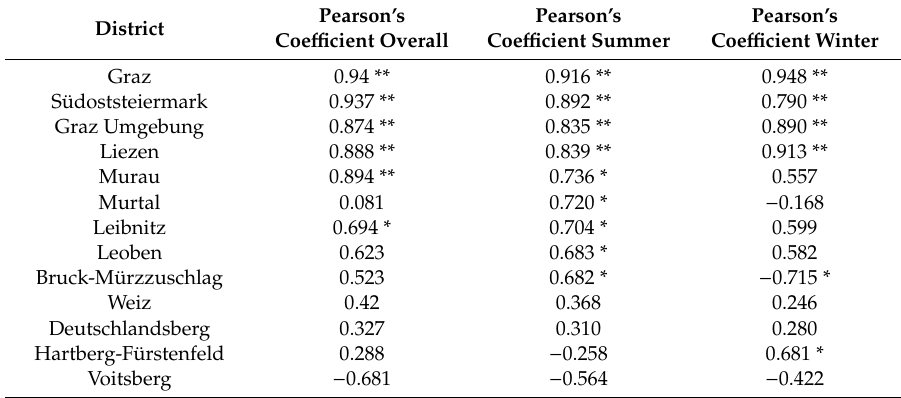
Table 3. Correlation coe ffi cients at a district level for tourism years 2011–2017 and for winter and summer season. The ** denote statistical significance at the 0.001 level, and * denotes statistical significance at the 0.005